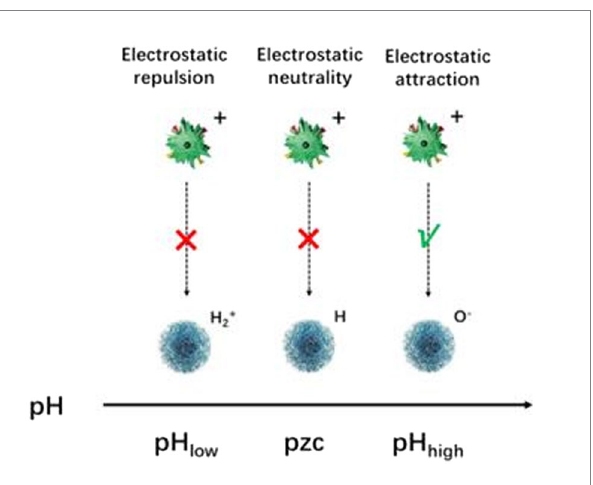
FIGURE 6 Schematic diagram of electrostatic interaction under different pH